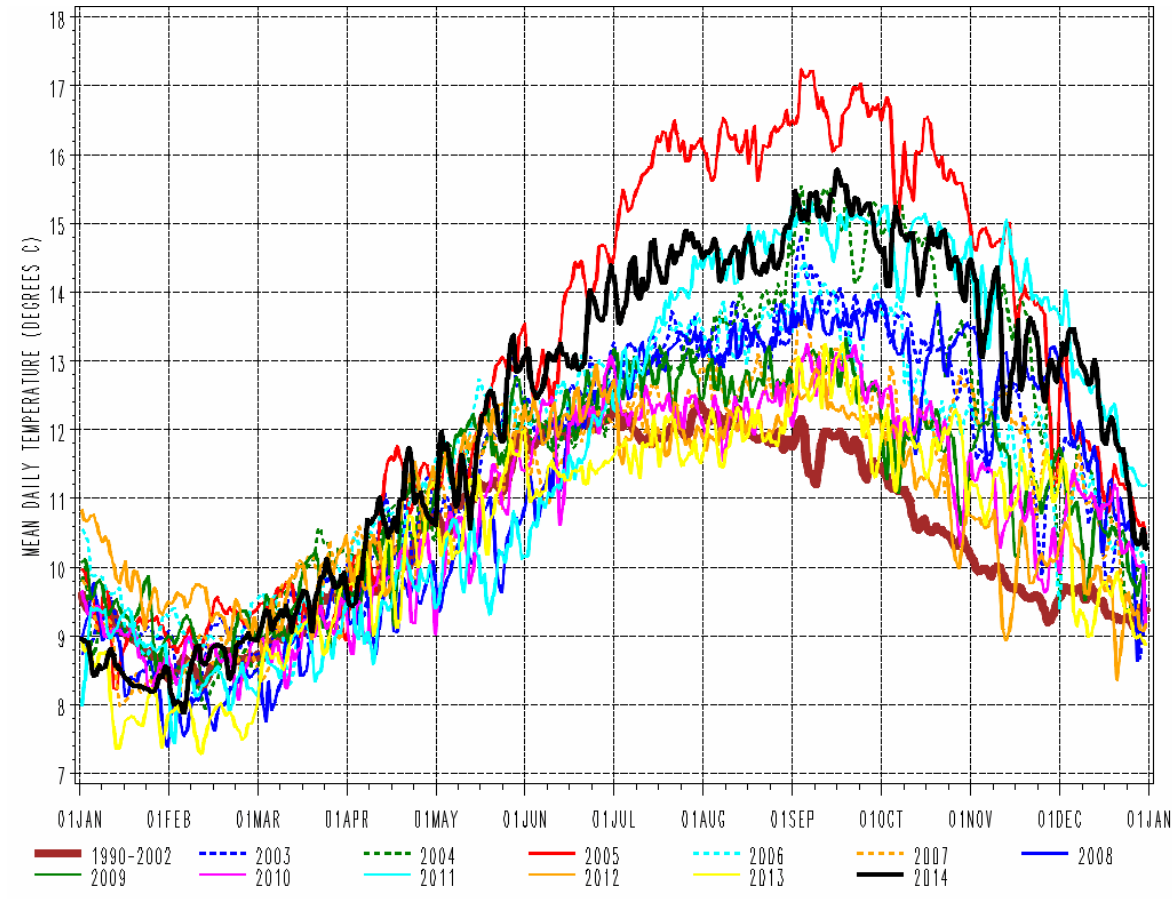
Figure A1.4. Long-term average (1990-2002) and annual trends of mean daily Colorado River ecosystem water temperature (data from US Geological Survey, Grand Canyon Monitoring and Research Center, after Voichick and Wright 2007) 122 km below the dam measured just upstream of the Little Colorado River confluence (2003-14). Following nine years of variable but relatively warmer downstream river temperatures, WY 2012-13 temperatures near the Little Colorado River were closer to the 1990-2002 average following Glen Canyon Dam releases in 2011 (annual dam releases in 2011, 2012 and 2013 were 15.4, 11.7 and 10.2 billion cubic meters, respectively). River temperatures near the Little Colorado River in WY 2014 were warmer in spring, similar in summer, but cooler in fall to winter compared to WY 2011 under the lowest annual dam release volume (9.2 billion cubic meters) since 1964. Such continuing year-to-year variation in the river’s thermal regime presents opportunity for experimental learning about aquatic resource responses to dam operation. (plot provided by W. Vernieu, US Geological